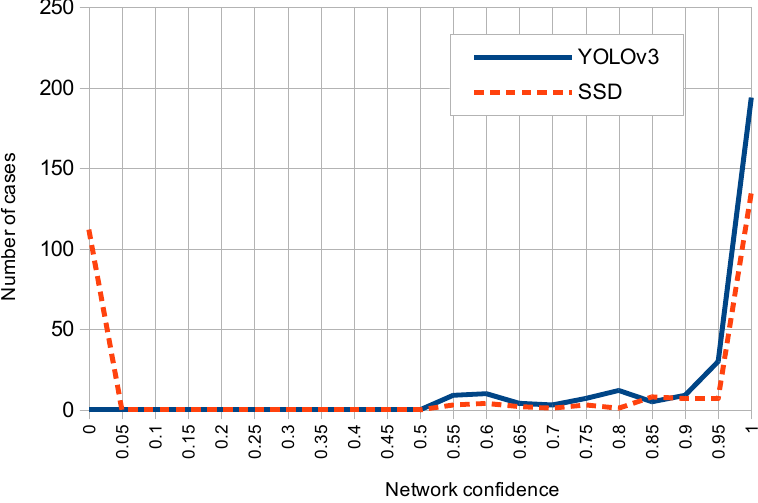
Figure 11. Histograms of respective network confidence distributions for SSD and YOLOv3.